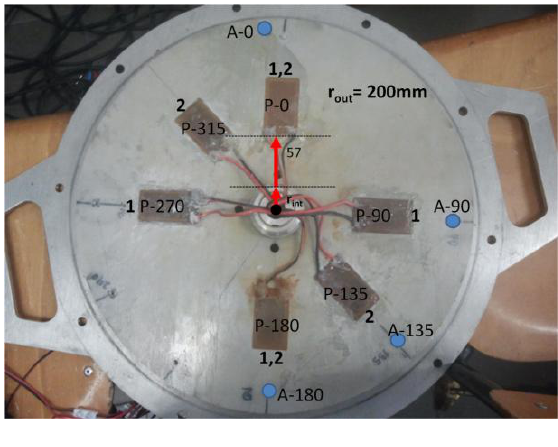
Figure 6. Rotating disk with installed PZTs and